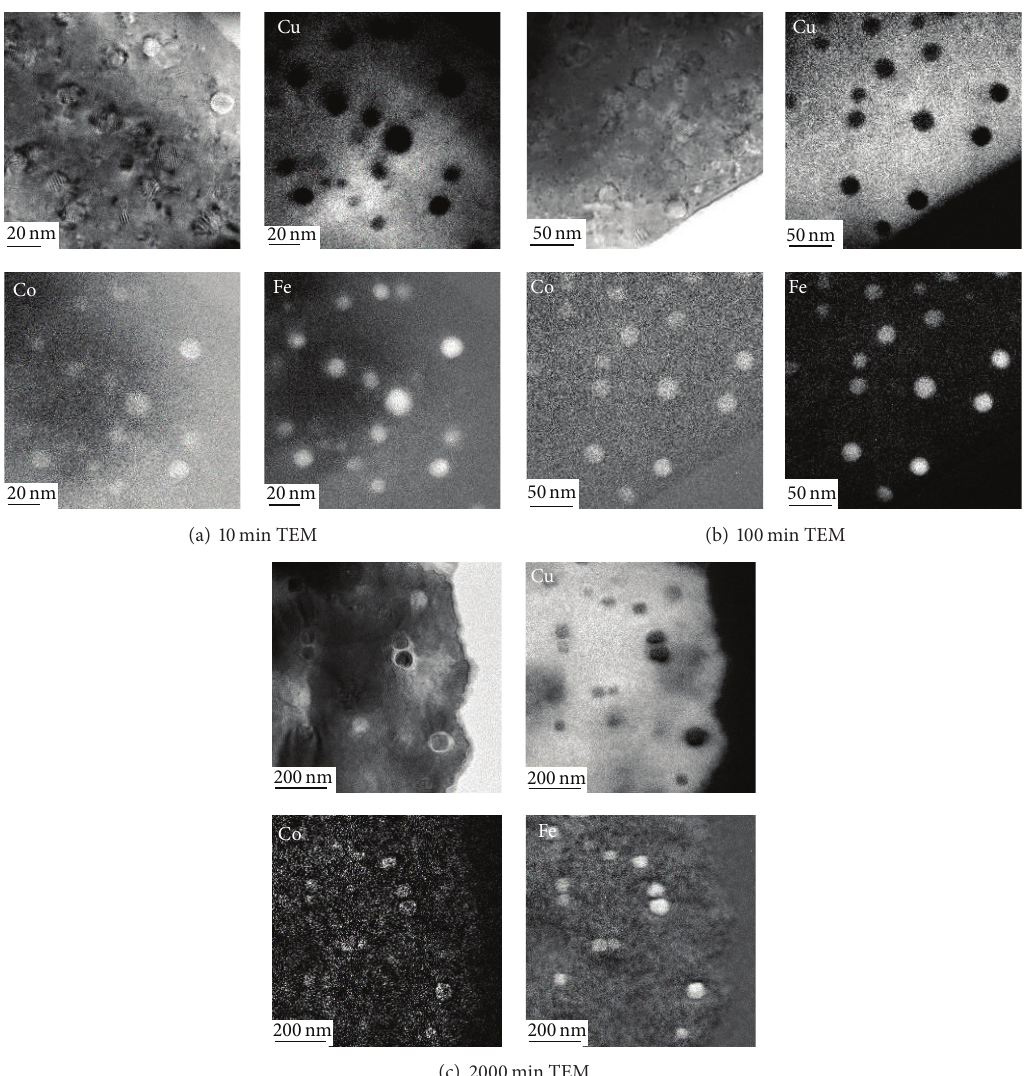
Figure 3: Elemental mapping images of precipitates with Cu, Fe, and Co EELS spectra in Cu-1.8at%Fe-1.2at%Co annealed at 973 K.